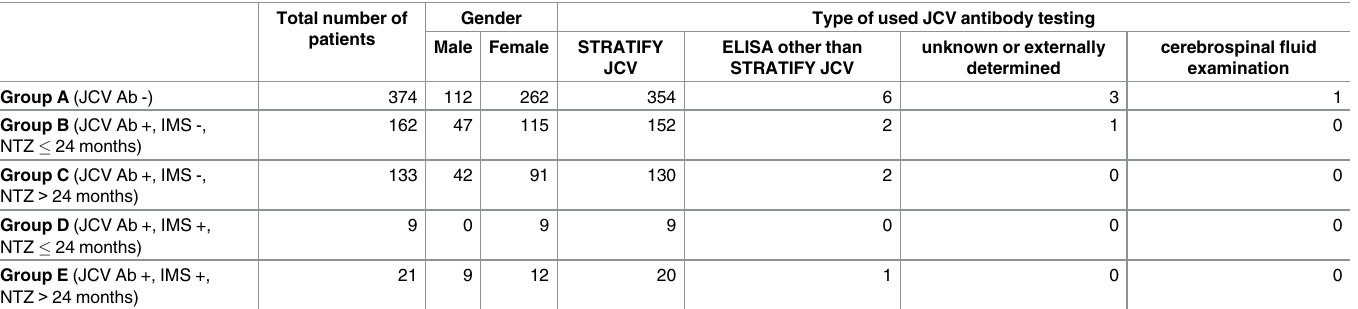
Table 2. Descriptivedemographic data of patients of the subgroups A-E at baseline. ELISA = enzyme-linked immunosorbent assays; IMS + /- = prior / no prior use of immunosuppressants; JCV Ab + /- = positive / negativeserostatus for anti-JCV antibodies;NTZ = natalizumab; NTZ > / (cid:20) 24 months = NTZ treatment longer/ less than 24